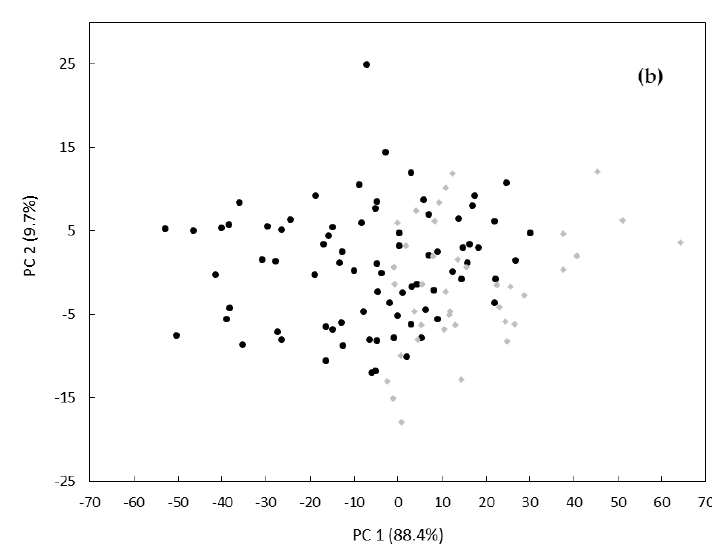
Figure 2. PC1 vs. PC2 scatter plots for monofloral chestnut ( a ) and acacia ( b ) honey samples. Geographical origins: Italy (black filled circle), Portugal (grey filled triangle), China (grey filled rhombus).